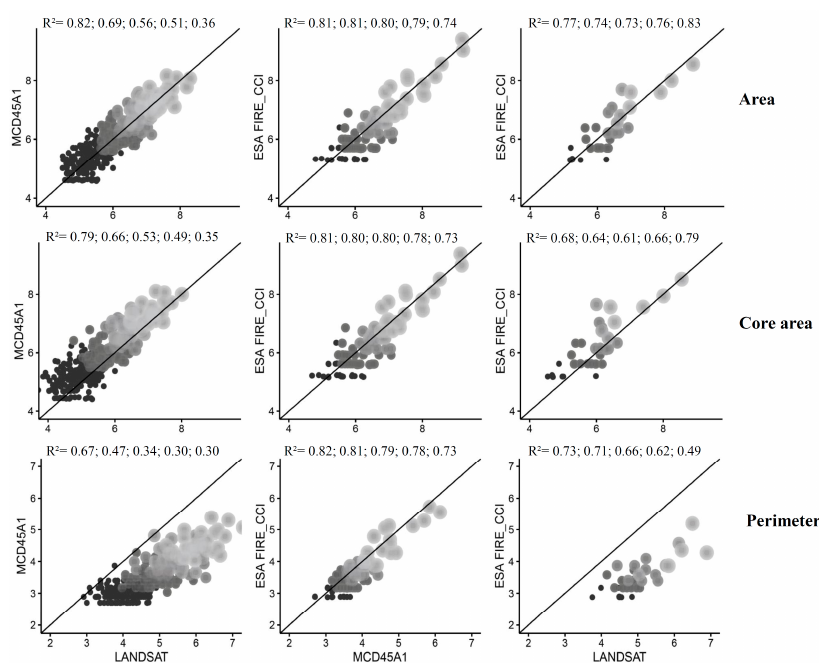
Figure A1. Correlations of (log transformed) patch metrics (Area in m 2 , Core area in m 2 , and Perimeter in m) for comparison: 1—LANDSAT × MCD45A1, 2—MCD45A1 × ESA FIRE_CCI and 3—LANDSAT × ESA FIRE_CCI. The grey scale color of individual points correspond to their patch size class from 90ha (black), 270ha, 450ha, 630ha, to 900 ha (light grey).The R squared values indicate the coefficient of determination ordered in according to patch size class.